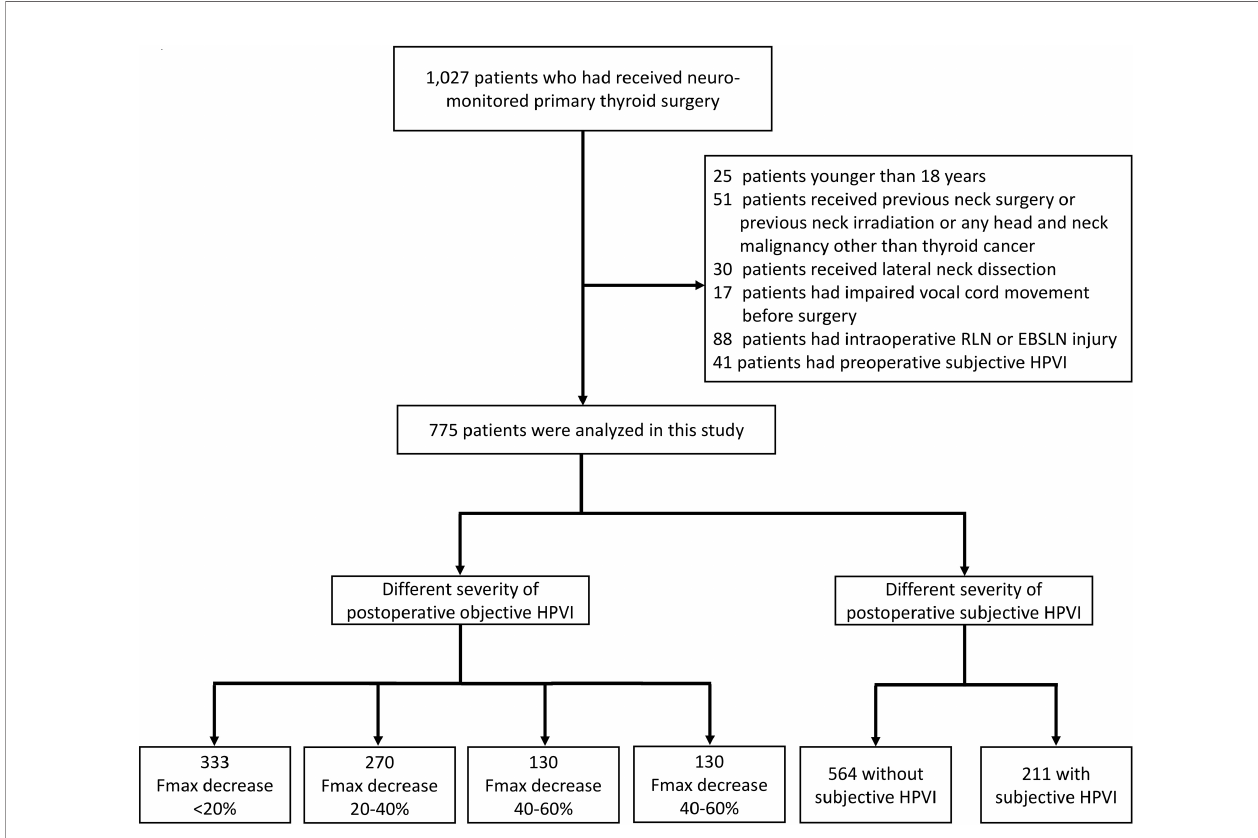
FIGURE 1 | Flow diagram for inclusion and exclusion of patients. RLN, recurrent laryngeal nerve; EBSLN, external branch of superior laryngeal nerve; HPVI, high- pitched voice impairment; Fmax, maximum pitch